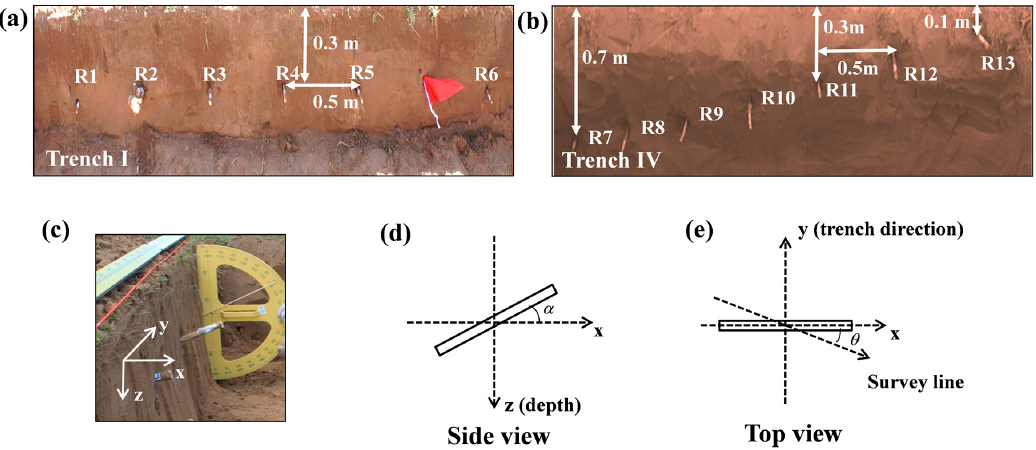
Figure 1. ( a ) Trench I for root orientation factor experiment in 2013. Diameters of the roots from R1 to R6 were 0.77, 2.22, 1.50, 1.32, 1.08, and 0.64 cm. Trenches II and III were similar to Trench I, but with roots of different vertical inclinations (30 ˝ and 45 ˝ , respectively); ( b ) Experiment for root depth factor. Diameters of the roots were between 1.1 and 1.3 cm; ( c – e ) The definition of the vertical inclination angle θ and the azimuth angle α